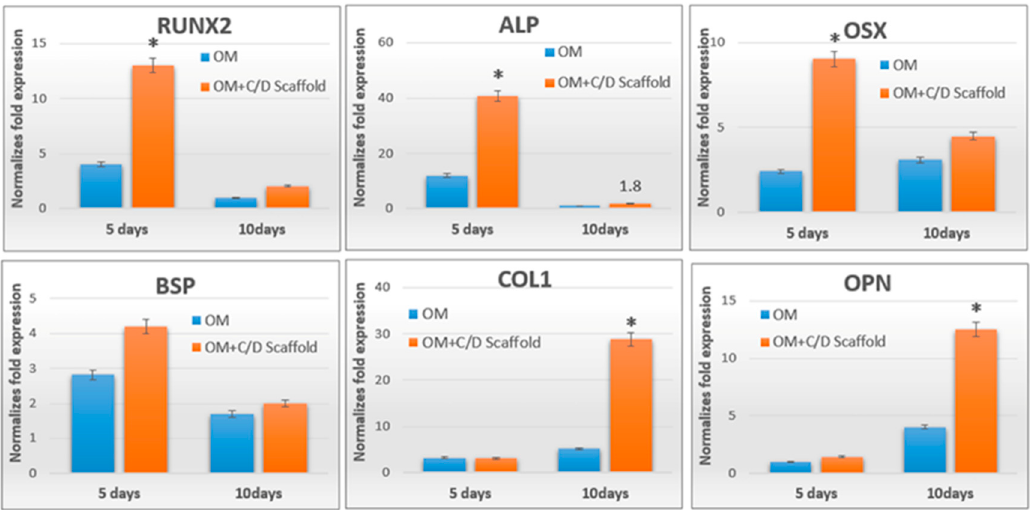
Figure 2. Real-time PCR for osteoblast differentiation associated gene expression, OM: osteogenic medium (independent samples t -test between OM group and OM+C/D scaffold group, * p < 0.05, n = 3) .